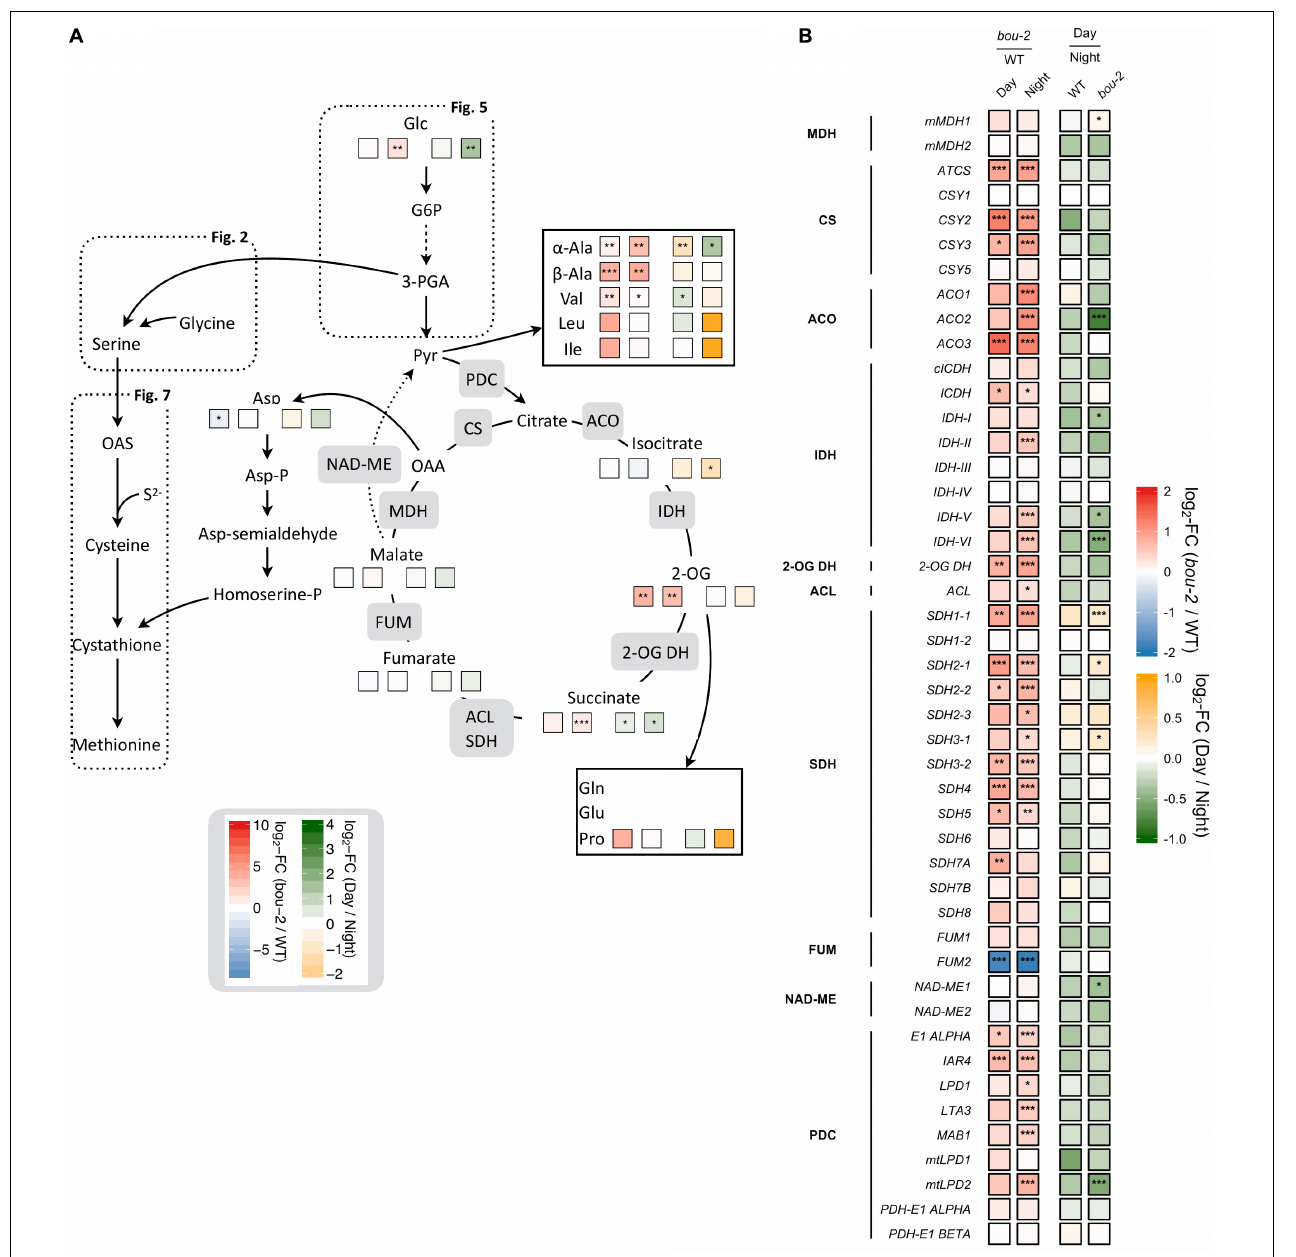
FIGURE 8 | Cross-talk of sulfur with nitrogen assimilation and catabolic carbon metabolism. (A) Schematic presentation of amino acids and other metabolites which closely interact with sulfur metabolism in serine and cysteine biosynthesis analyzed in leaves of the A. thaliana WT and the bou - 2 mutant at day and night exposure ( n = 4). (B) Transcript levels ( n = 3) of genes encoding for enzymes of the tricarboxylic acid (TCA) cycle. Left two tiles represent the log2-fold change (FC) between the bou-2 mutant and the WT plants at both day (D) and night (N) exposure with false color code ranging from red (higher in bou-2 ) to blue (higher in WT). Right two tiles represent the log2-fold change (FC) between day and night exposure within the WT plants and bou-2 mutant with false color code ranging from green (higher at night) to yellow (higher at day). Asterisks indicate significantly different metabolite levels (A) as determined by Student’s t -test ( ∗ p < 0.05, ∗∗ p < 0.01, and ∗∗∗ p < 0.00) or differential gene expression (B) as determined by Sleuth ( ∗ FDR < 0.05, ∗∗ FDR < 0.01, and ∗∗∗ FDR < 0.001). 1, malate dehydrogenase (MDH); 2, citrate synthase (CSY); 3, aconitase (ACO); 4, isocitrate dehydrogenase (IDH); 5, 2-OG dehydrogenase (2OG DH); 6, Succinate-CoA ligase (ACL); 7,